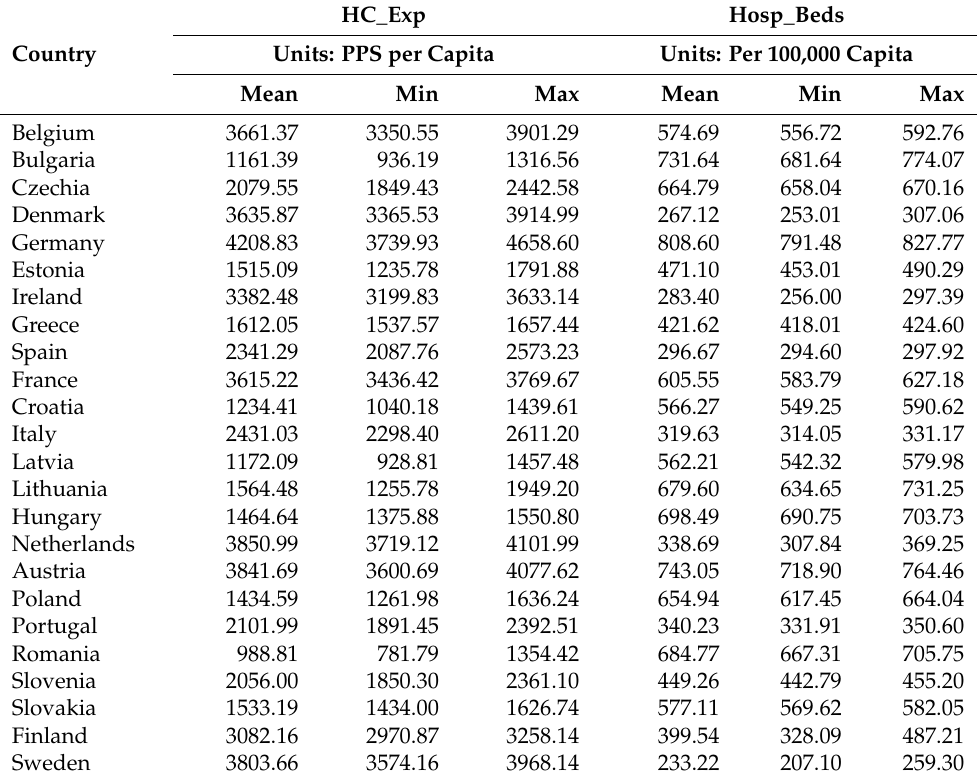
Table 1. Descriptive statistics of the